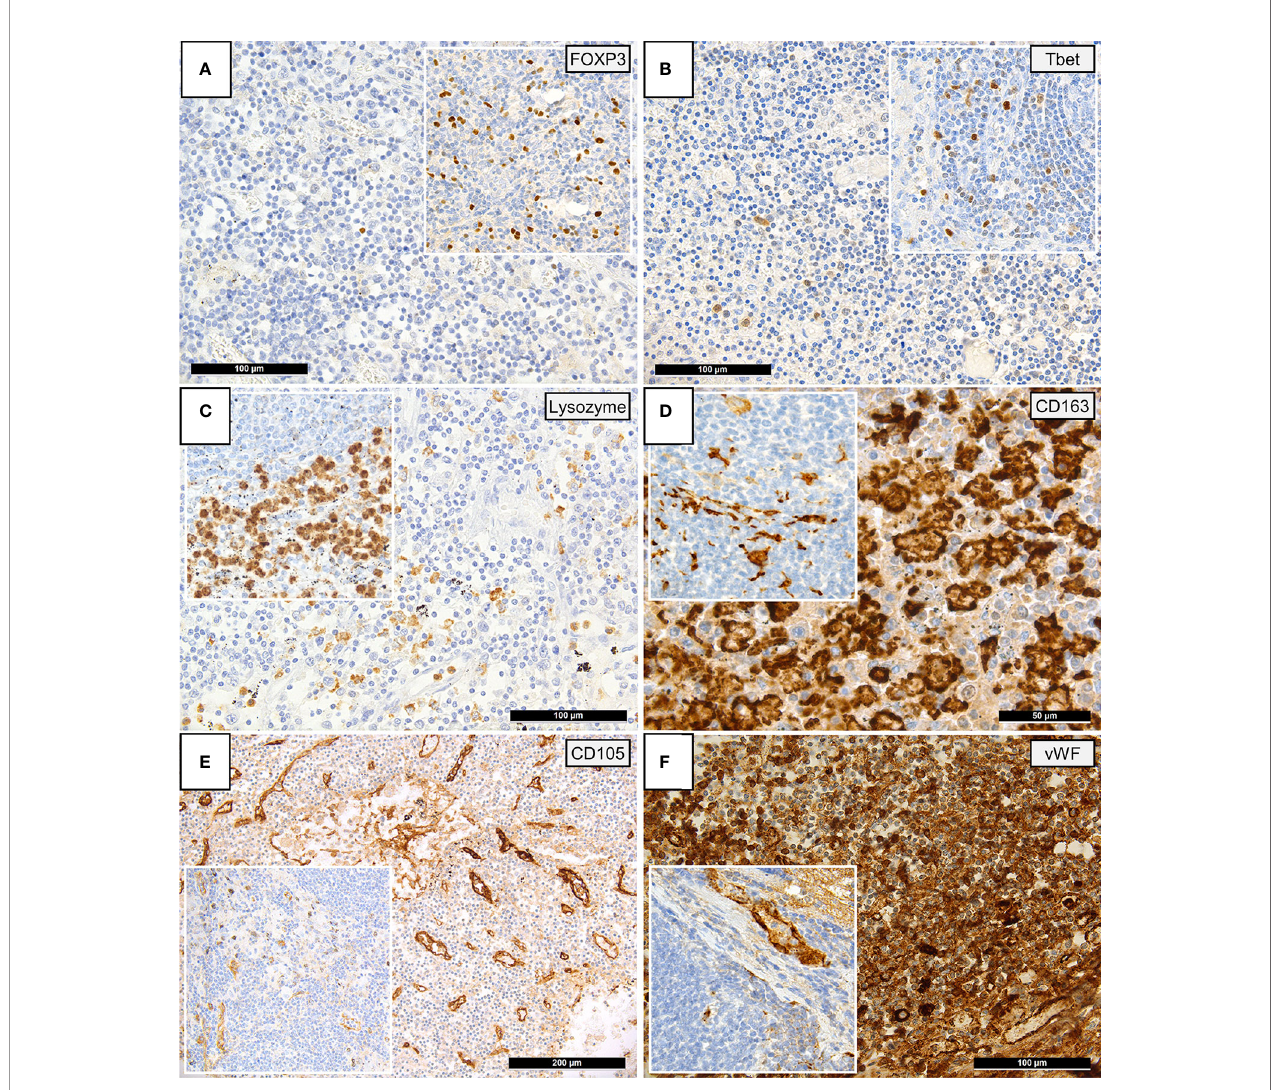
FIGURE 2 | Immunohistochemical Patterns of a Dysregulated Immune Response in COVID-19. Insets display immunohistochemical stainings in controls. (A) Paucity of FOXP3-positive Tregs in COVID-19 patients compared to controls (immunoperoxidase; 280x). (B) Reduced amounts of Tbet positive T-helper 1 (TH1) cells in COVID-19 versus controls (immunoperoxidase; 280x). (C) Reduced amounts of lysozyme-positive histiocytes/macrophages in the paracortex of COVID-19 lymph nodes versus controls (immunoperoxidase; 280x). (D) Increased amounts of CD163-positive histiocytes/macrophages in the paracortex of COVID-19 lymph nodes versus controls (immunoperoxidase; 400x). (E) Increased CD105-positive microvessel density in COVID-19 lymph nodes versus controls (immunoperoxidase; 50x). (F) Increased amount of vWF expression in COVID-19 lymph nodes, vWF positivity in controls is limited to the vascular wall (inset) (immunoperoxidase;